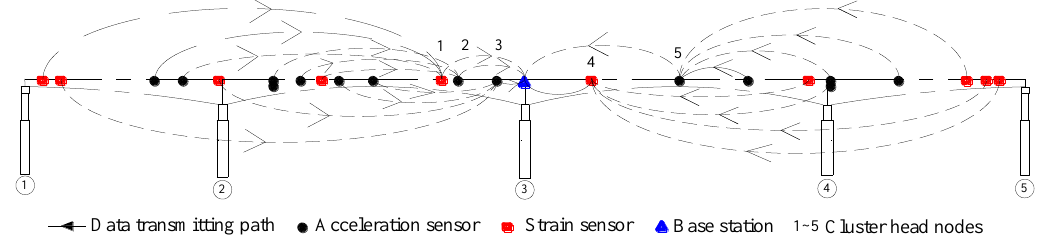
Figure 8. Cluster-tree topology configuration.